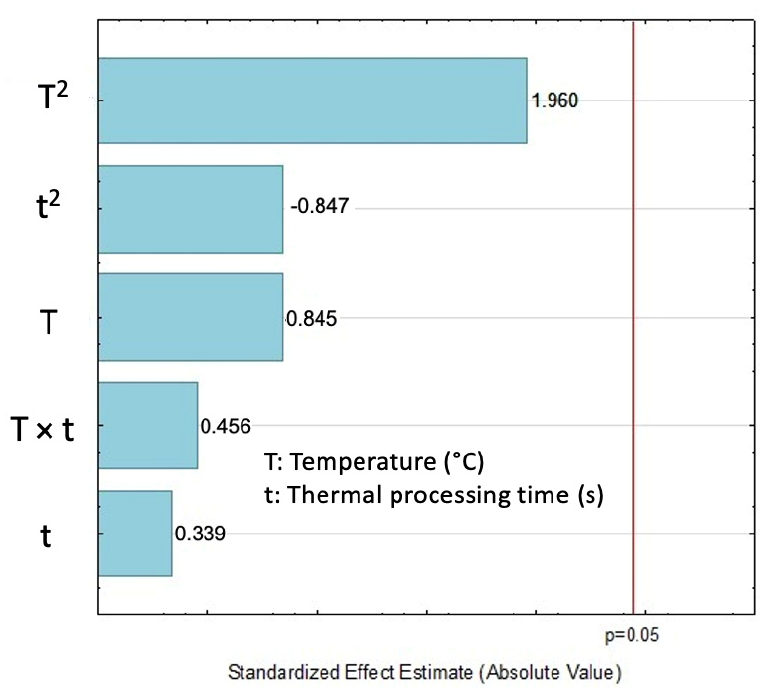
Figure 3. Effect of steam processing temperature “T” (°C) and thermal processing time: “t” (s) on AOX (%) of EO: Pareto chart.